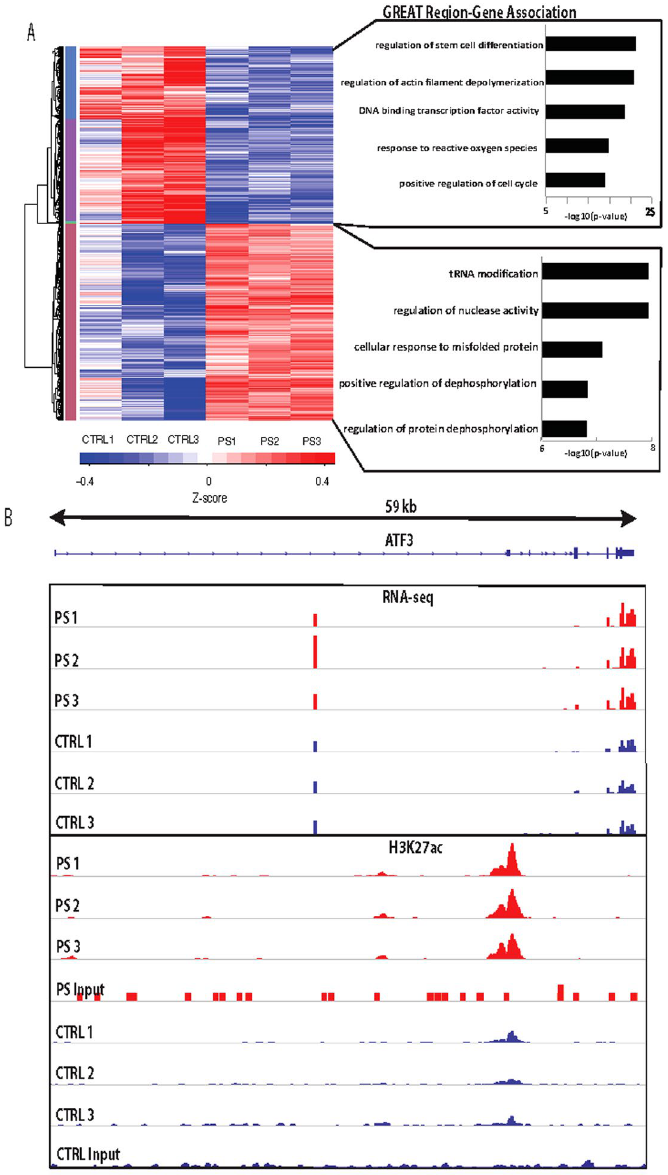
Figure 3. ChIP-seq analysis of PenStrep responsive peaks in HepG2 cells. ( A ) The top right panel shows a heatmap depicting z-scores as relative expression levels normalized to input per peak for all 9,514 differentially enriched H3K27ac peaks across all three replicates per treatment. To the right, are shown the top region-gene association pathways according to GREAT 29 . ( B ) Integrative genomic viewer snapshot showing RNA-seq and H3K27ac ChIP-seq results in the ATF3 locus. The scale for the RNA-seq tracks was normalized per million mapped reads (e.g. coverage/(total mapped reads/1 M)). The vertical scale for the ChIP-seq tracks is set to a scale of zero to one, with zero defined as the median coverage of the genome and one defined as the top (99.9 th ) percentile of reads counted in any given 100 bp window. This locus shows increased ATF3 expression in the PenStrep- treated HepG2 cells (red) versus vehicle control treated cells (blue) observed through RNA-seq, as well as ChIP-based enrichment of H3K27ac in PenStrep-treated cells (red) versus vehicle control treated cells